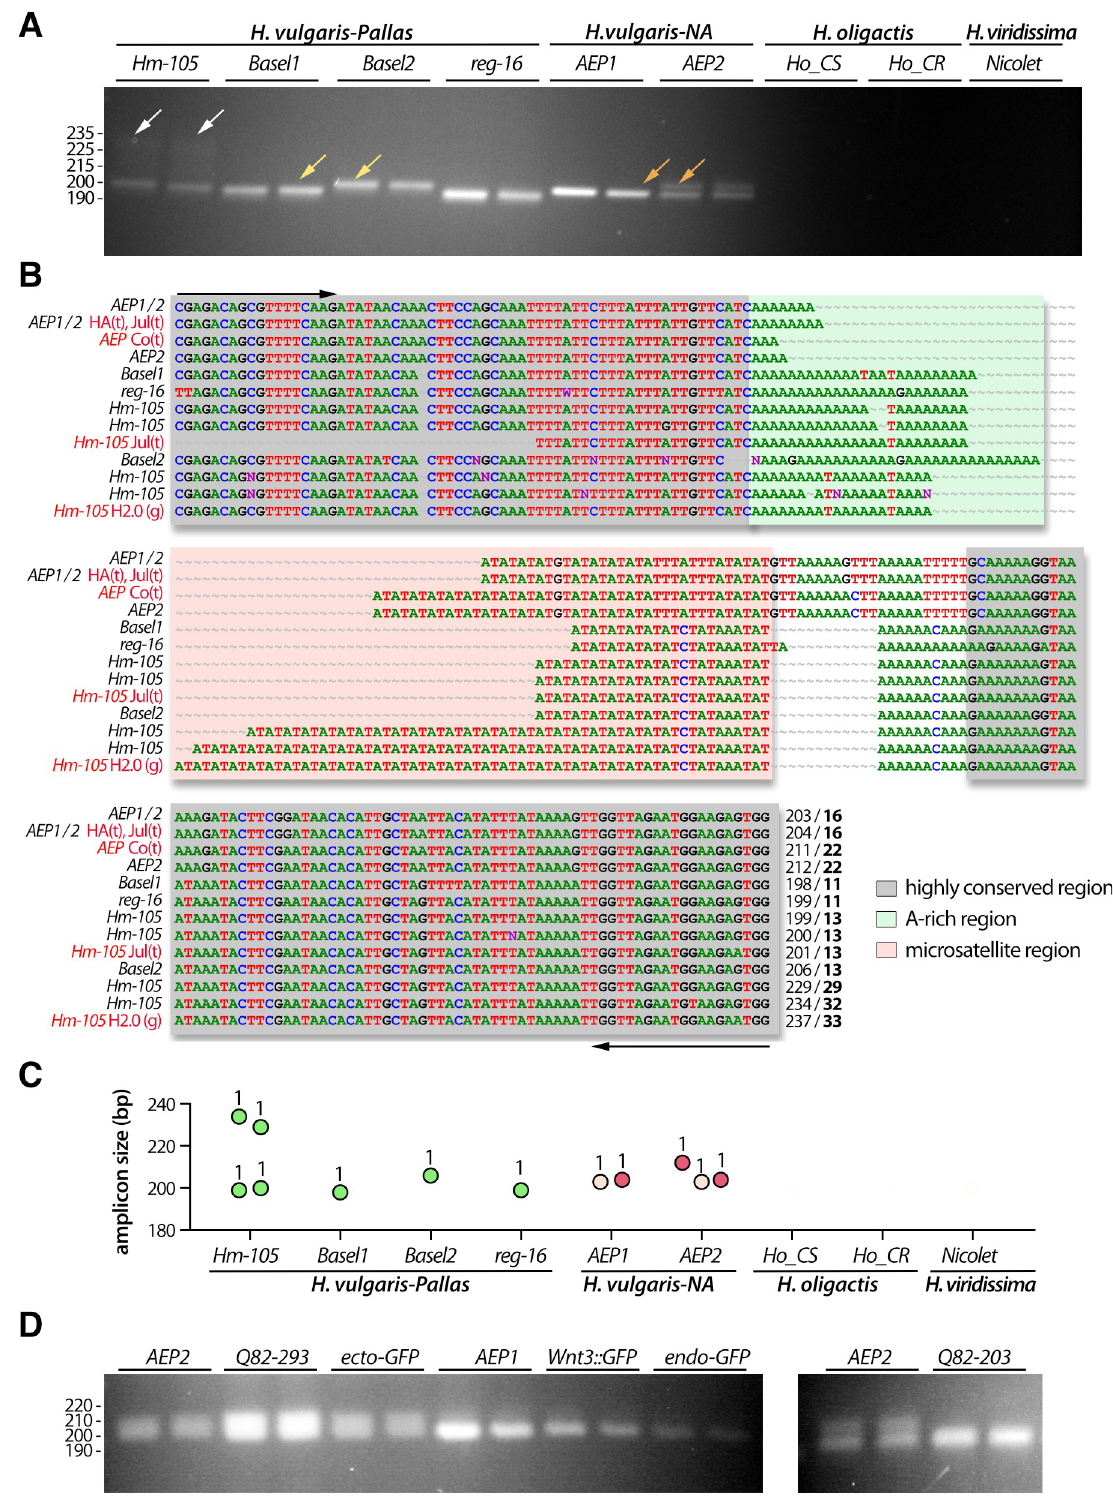
Fig 5. Analysis of the polymorphism of the AT-rich microsatellite region of the Aryl-Hydrocarbon Receptor-Interacting Protein gene (ms-AIP) . (A) Amplification of the ms-AIP genomic sequences in six out of nine tested strains, which represent two distinct H . vulgaris sub-groups, H . vulgaris-Pallas ( Basel1 , Basel2 , Hm-105 , reg-16 ) and H . vulgaris-NA ( AEP1 , AEP2 ). White arrows point to a faint